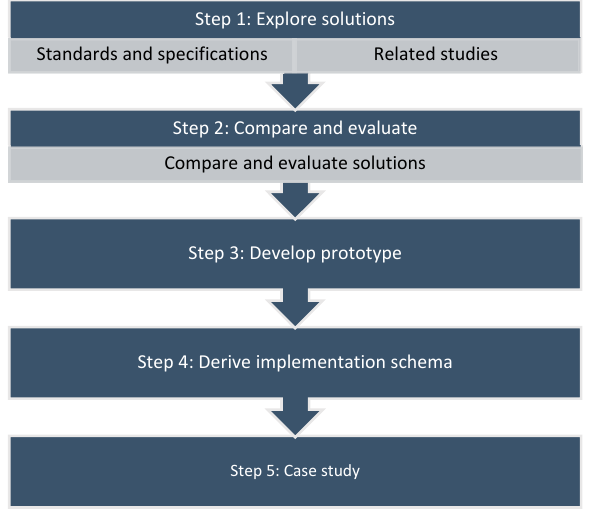
Figure 3. Steps in the research.